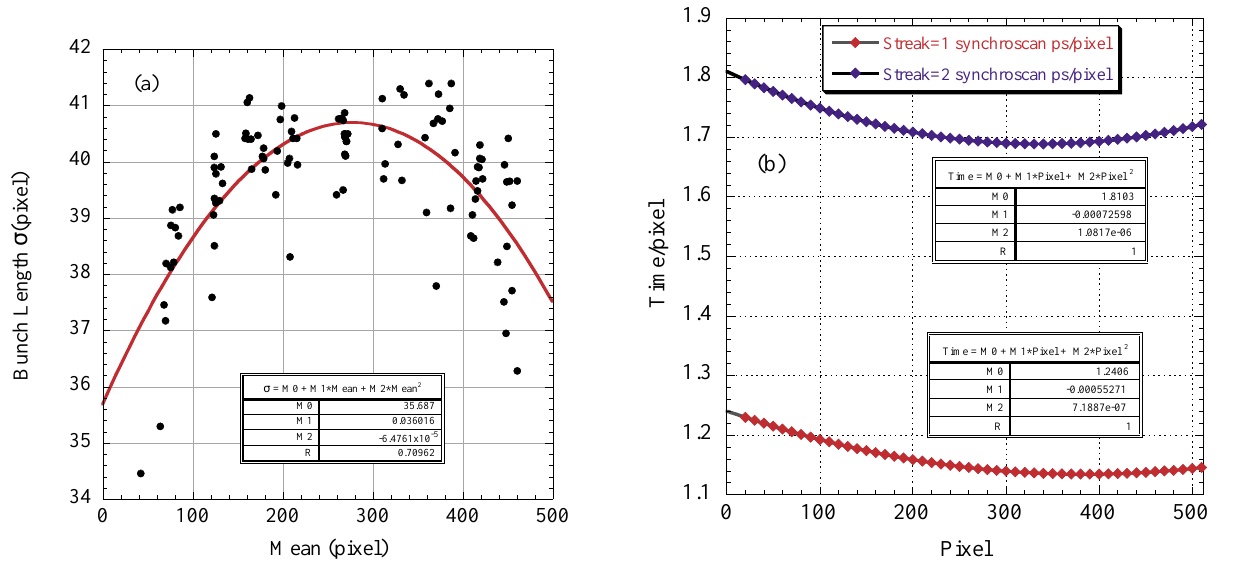
FIG. 8. (Color) (a) The measured bunch length at different trigger settings without the calibration correction and (b) the synchroscan unit calibration curve.